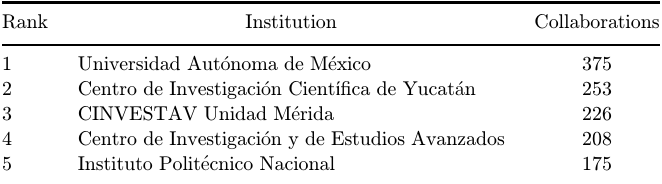
Table 3. Ranking of Mexican institutions with the greatest collaboration with